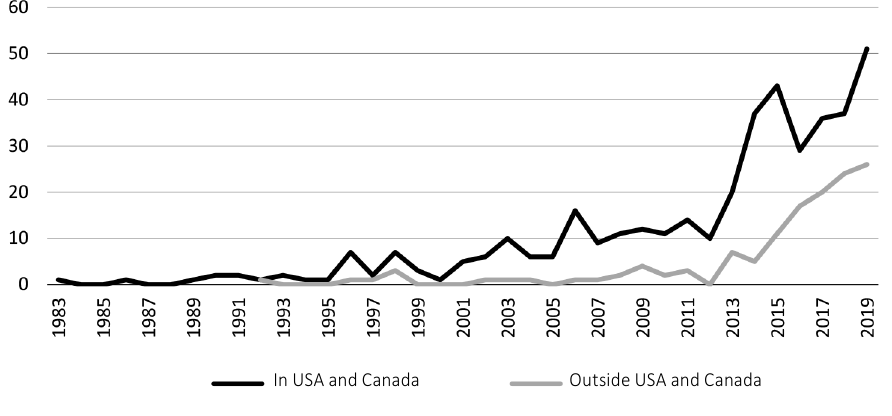
Note: no data available for